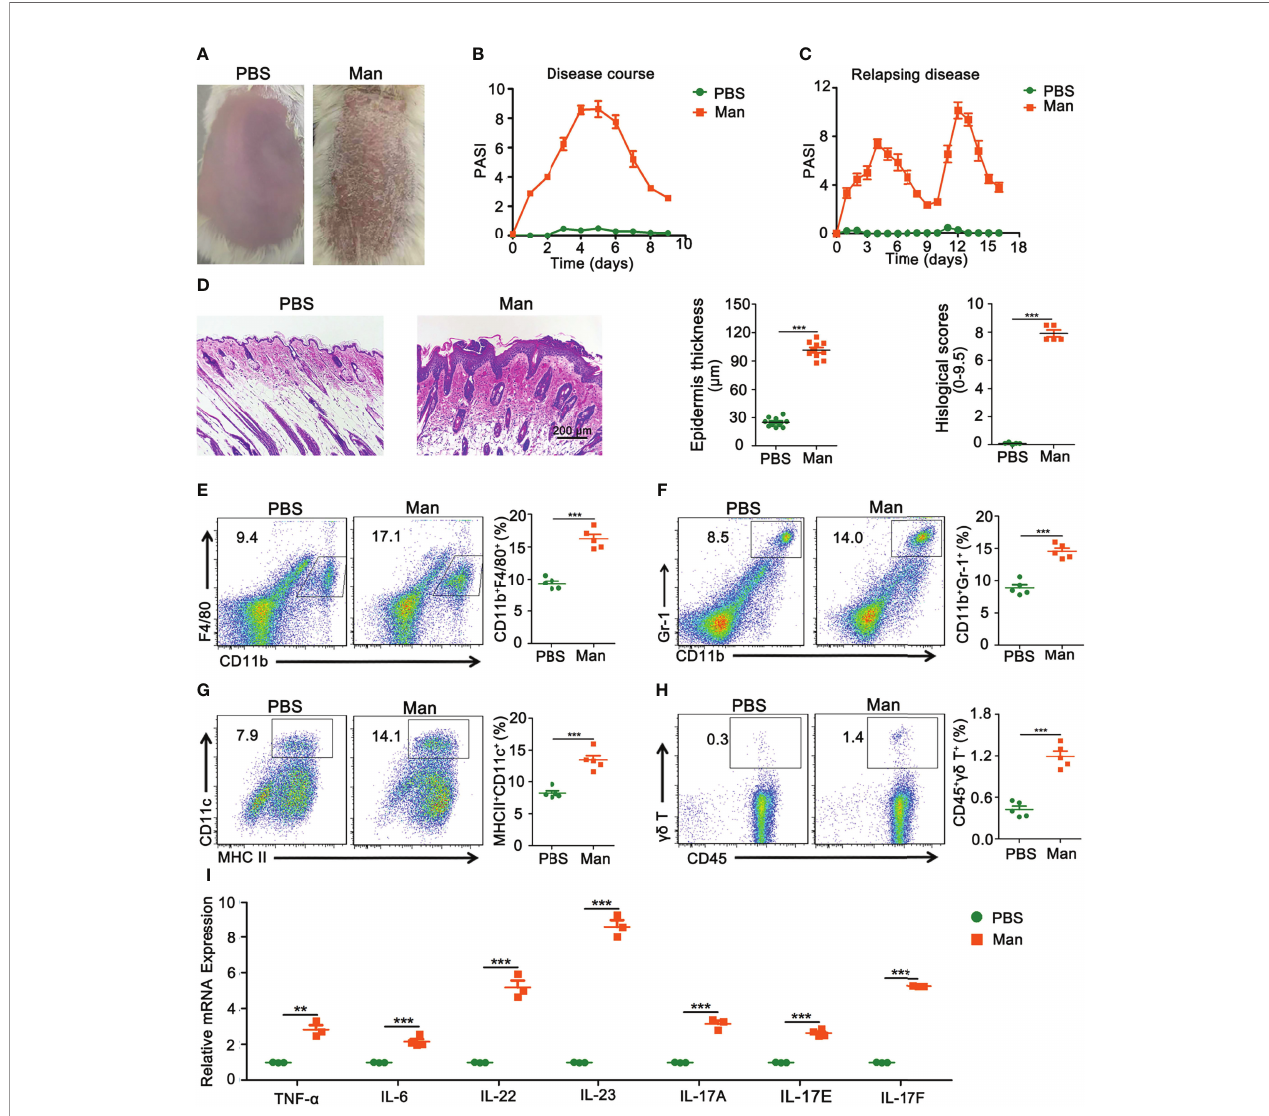
FIGURE 1 | Characterization of mannan-induced skin in fl ammation. (A) Representative pictures of mouse skin after PBS or mannan application on Day 5 (n = 10/group). (B) Disease course after mannan or PBS application mixed with IFA in BALB/c mice on three consecutive days starting from Day 0 (n = 10/group); (C) relapsing mannan- induced skin in fl ammation (n = 10/group); (D) representative pictures of HE staining of psoriatic skin and statistical results of epidermal thickness with histological scores at peak of psoriasis (Scale bars: 200 m m) (n = 5/group). Representative pictures and statistical results on the expression of (E) macrophages (CD11b + F4/80 + ), (F) neutrophils (CD11b + Gr-1 + ), and (G) dendritic cells (MHCII + CD11c + ) expression in spleen in mannan-induced skin in fl ammation on Day 5 (n = 5/group). (H) Representative pictures and percentage of gd T cells (CD45 + gd T + ) after PBS or mannan application on Day 5 in the draining lymph nodes (n = 5/group). (I) Expression of IL-23/IL-17 axis and its upstream cytokines (IL-6, TNF- a ) (n = 3/group). Man, mannan. Statistical analyses were performed using an unpaired t test and n indicates number of mice in each group. The data represent mean ± SEM. **p < 0.01. ***p <